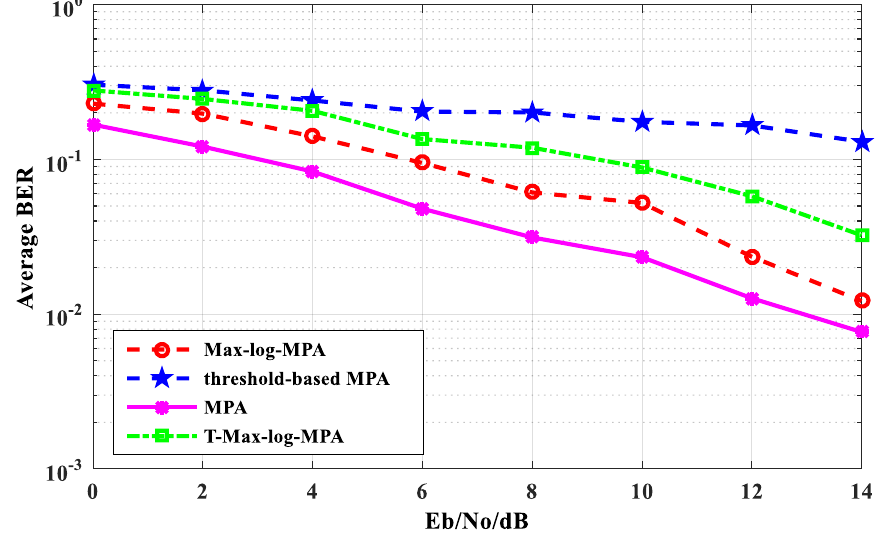
Figure 5. The comparison of average BER performance in four algorithms.